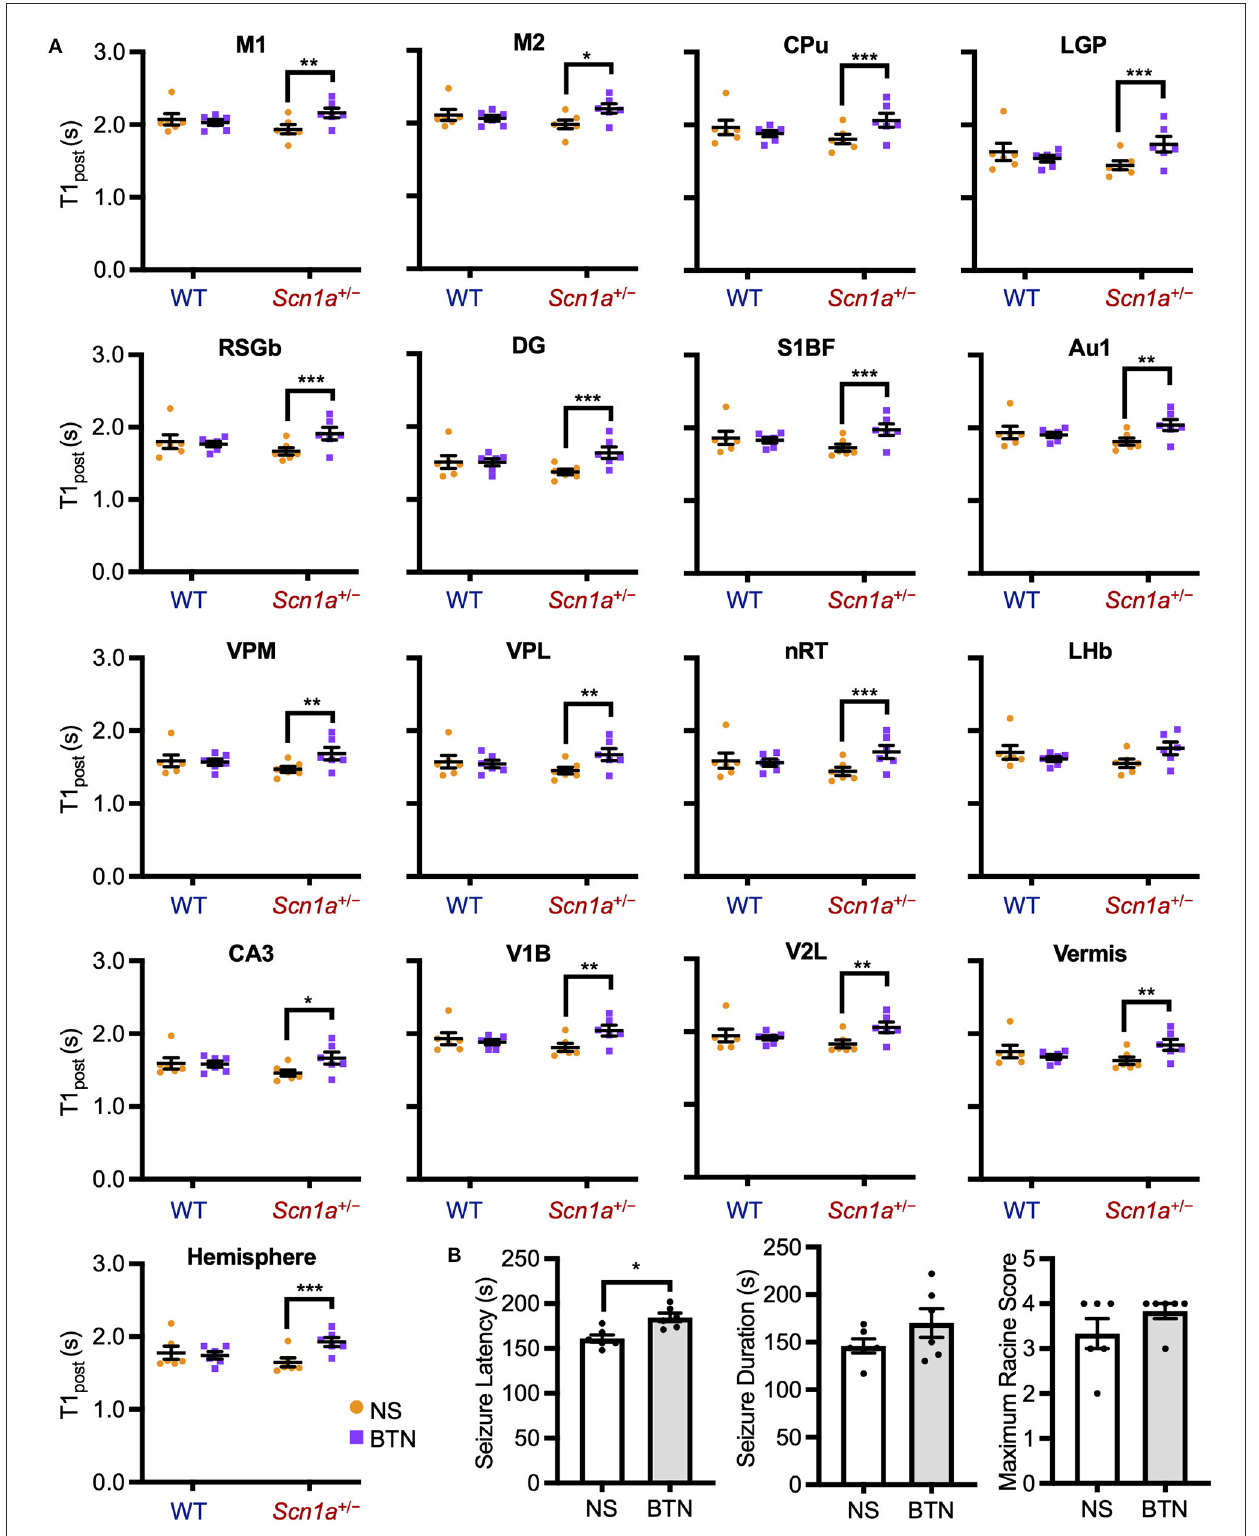
FIGURE4 T1 post and seizure characteristics after administration of BTN or NS. (A) Scheffé multiple-comparison test of T1 post in rats at P21 after the administration of BTN (orange circle) or NS (purple square). Scn1a + / − rats showed a significant increase in the T1 post of widespread brain regions in the BTN-treated group compared to the NS-treated group: M1 (mean difference − 0.225s; 95% CI − 0.423- − 0.027s), M2 (-0.210s; − 0.408 − 0.011s), CPu (-0.260s; − 0.458 − 0.062s), LGP (-0.288s; − 0.486 − 0.090s), RSGb (-0.236s; − 0.435 − 0.037s), DG (-0.265s; − 0.463 − 0.067s), S1BF (-0.235s; − 0.435 − 0.035s), Au1 (-0.222s; − 0.421 − 0.024s), VPM (-0.216s; − 0.414 − 0.018s), VPL (-0.223s; − 0.420 − 0.025s), nRT (-0.272s; − 0.470 − 0.074s), LHb (-0.197s; − 0.396 − 0.002s), CA3 (-0.200s; − 0.397 − 0.002s), V1B (-0.222s; − 0.420 − 0.023s), V2L (-0.223s; − 0.422 − 0.024s), Vermis (-0.213s; − 0.412 − 0.015s), and Hemisphere (-0.272s; − 0.471 − 0.073s). There was no difference between the T1 post of NS-treated and BTN-treated